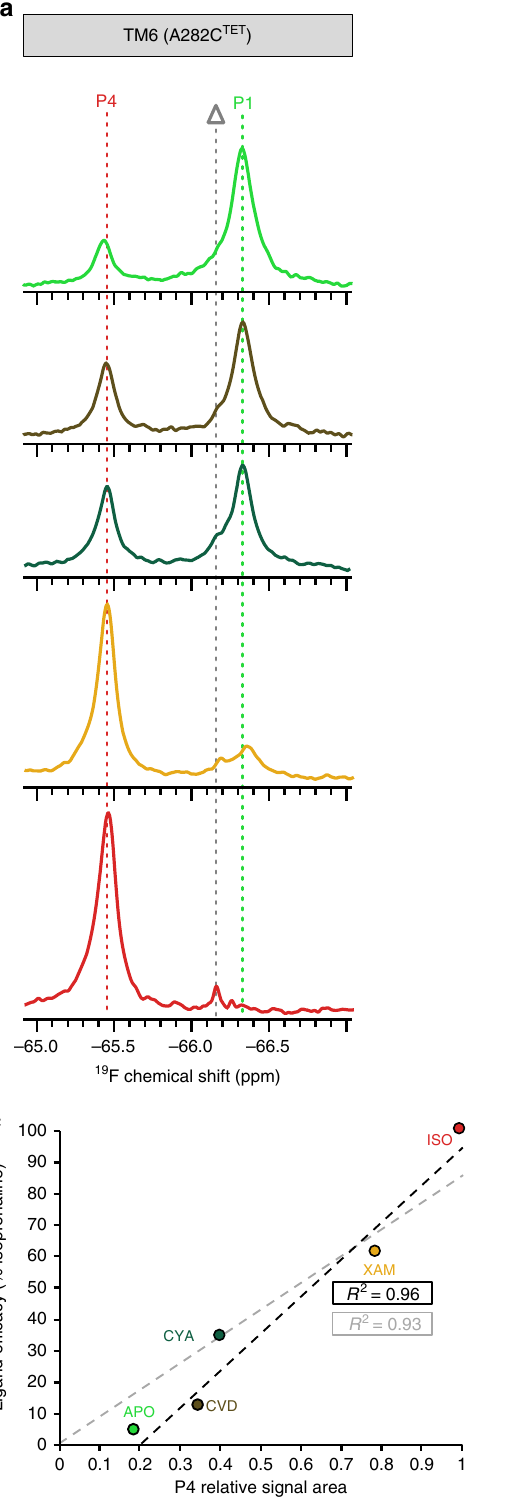
bound agonist (Fig. 2b, c, Supplementary Fig. 6b). At the same time P2 also displayed increasing line-broadening (Fig. 2d). 19 F CPMG relaxation dispersion experiments conducted at two fi elds for the receptor bound to isoprenaline revealed the presence of a fast exchange process with the receptor interconverting between two conformations, (I 1 ) and (I 2 ), with a rate k ex = 2,878 ± 317 s − 1 (Fig. 2e). For xamoterol the exchange rate was reduced